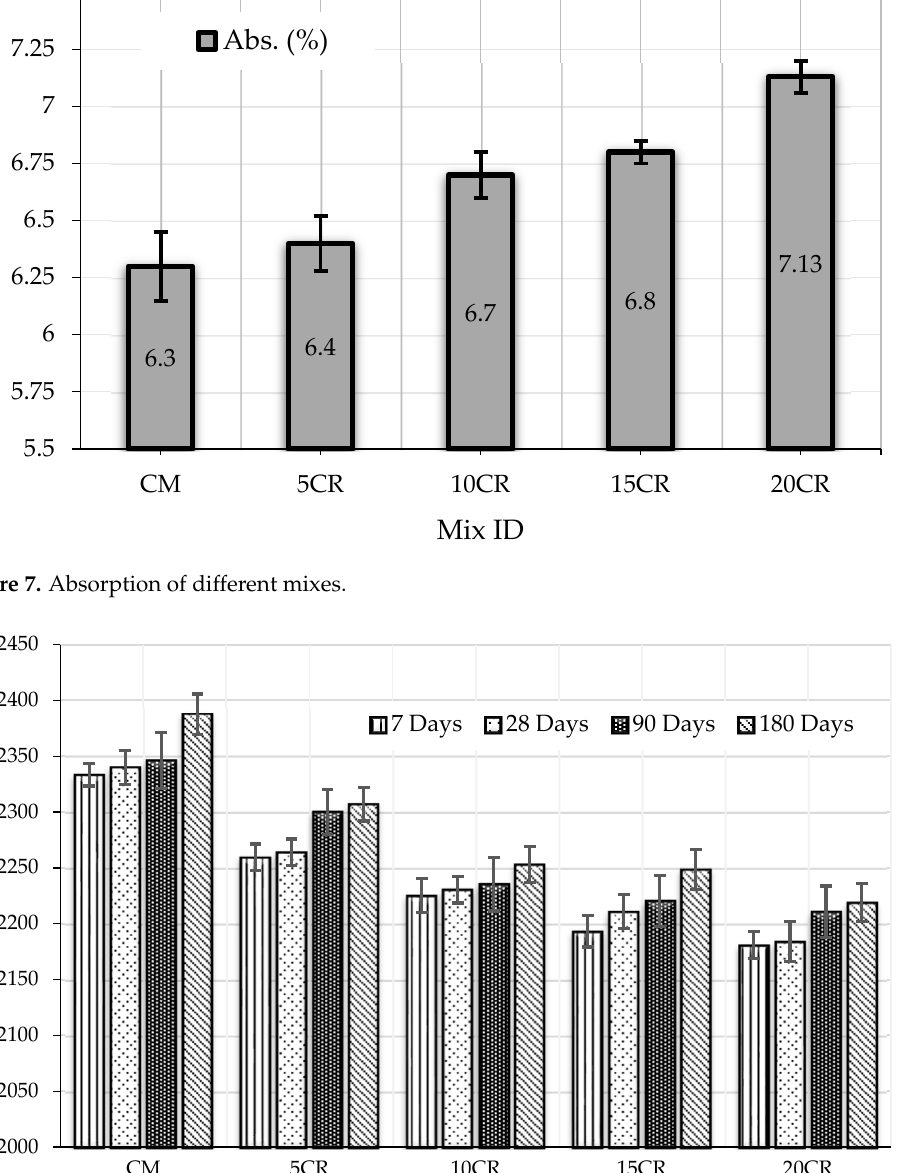
Figure 7. Absorption of different mixes.